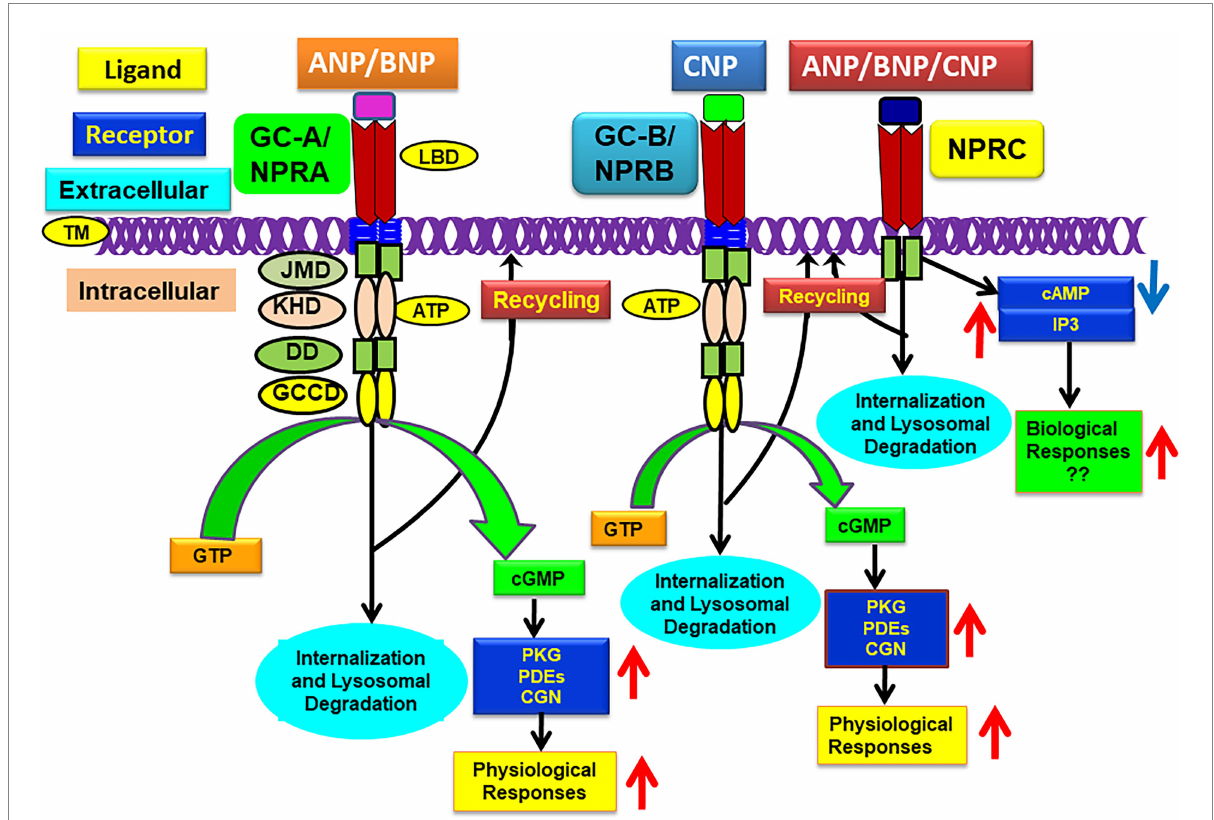
FIGURE 1 Schematic representation of ligand-dependent activation and physiological functions of GC-A/NPRA, GC-B/NPRB, and NPRC. ANP and BNP binding to amino-terminal domain activates GC-A/NPRA, which leads to enhanced production of intracellular second messenger cGMP with stimulation of PKG, PDFs, and CNG that activate ANP-dependent cellular and physiological responsiveness. CNP binds and activates GC-A/NPRB and also produces cGMP and physiological responsiveness. All three NPs activate NPRC that lead to some biological actions. ANP, atrial natriuretic peptide; BNP, brain natriuretic peptide; CNP, C-type natriuretic peptide; GC-A/NPRA, guanylyl cyclase-A/natriuretic peptide receptor-A; GC-B/ NPRB, guanylyl cyclase-B/natriuretic peptide receptor-B; NPRC, natriuretic peptide clearance receptor; LBD, ligand binding domain; TM, transmembrane domain; KHD, protein-kinase like homology domain; DD, dimerization domain; GCCD, guanylyl cyclase catalytic domain; IP 3 , inositol trisphosphate. Adopted with modification from reference Pandey, K. N. 2015, Membranes 5,